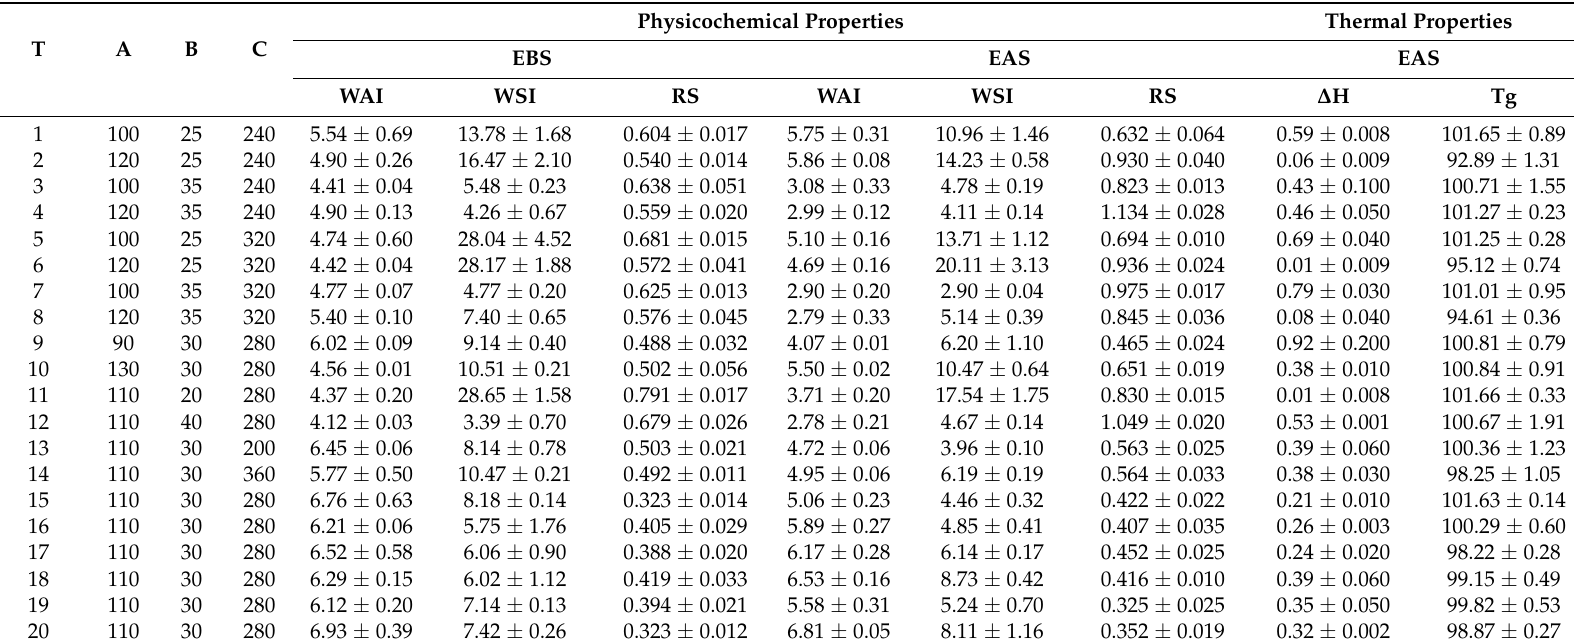
Table 2. Physicochemical and thermal properties of extruded cornstarch at different process